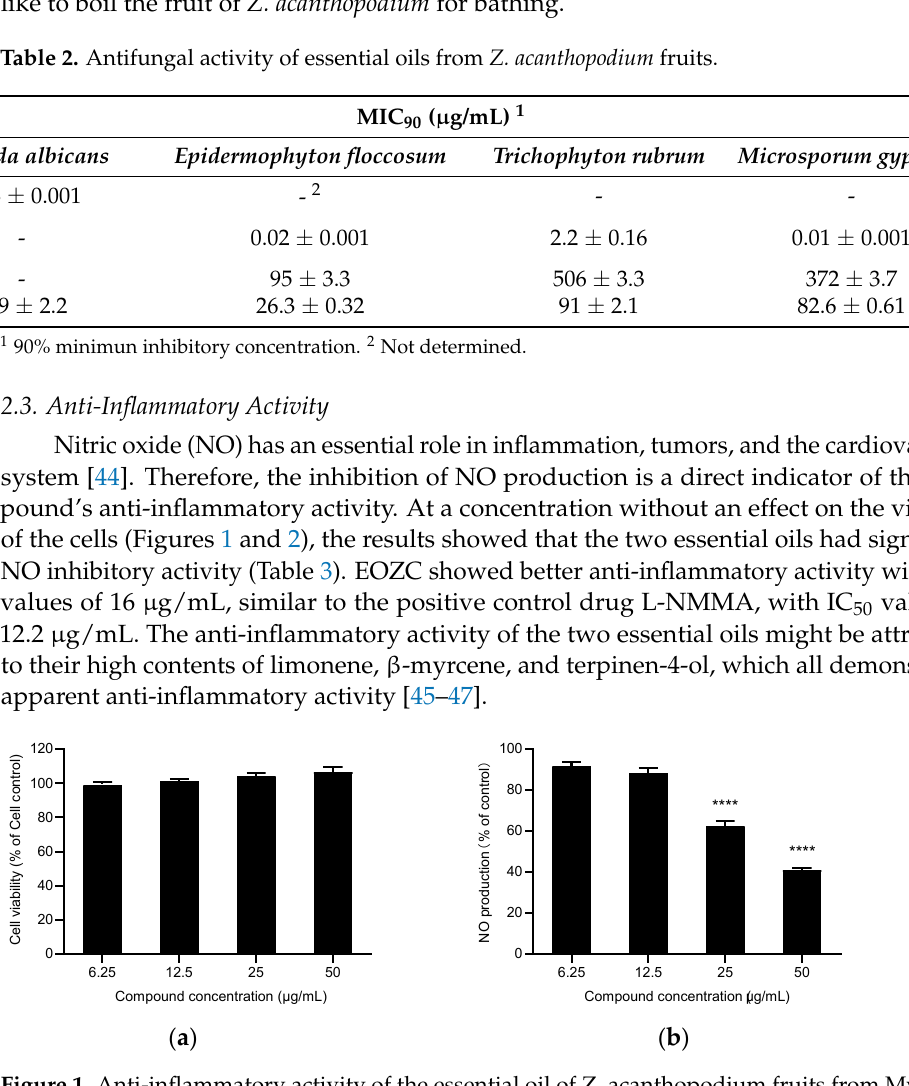
Figure 1. Anti-inflammatory activity of the essential oil of Z. acanthopodium fruits from Myanmar (EOZM). ( a ) The cytotoxicity of EOZM in RAW 264.7 cells. Cell viability were by MTS assay. ( b ) The inhibitin of EOZM on LPS-induced NO production in RAW 264.7 cells. Results were presented as mean ± standard deviation (SD) of three independent tests, **** p < 0.0001. Table 3. Anti-inflammatory activity of essential oils from Z. acanthopodium